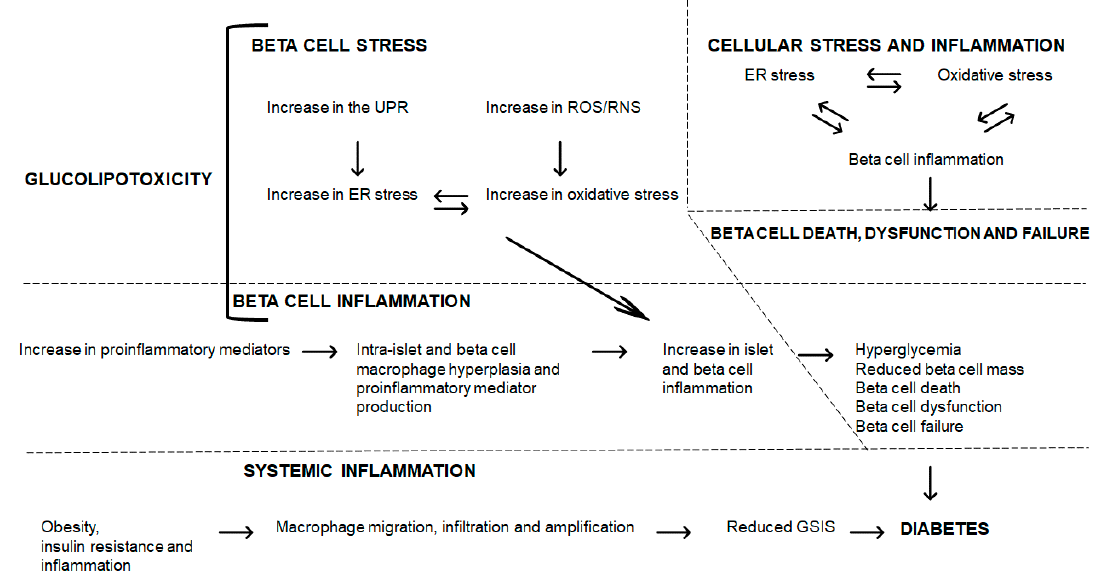
Figure2. Glucolipotoxicity, betacellstress, andinflammation: